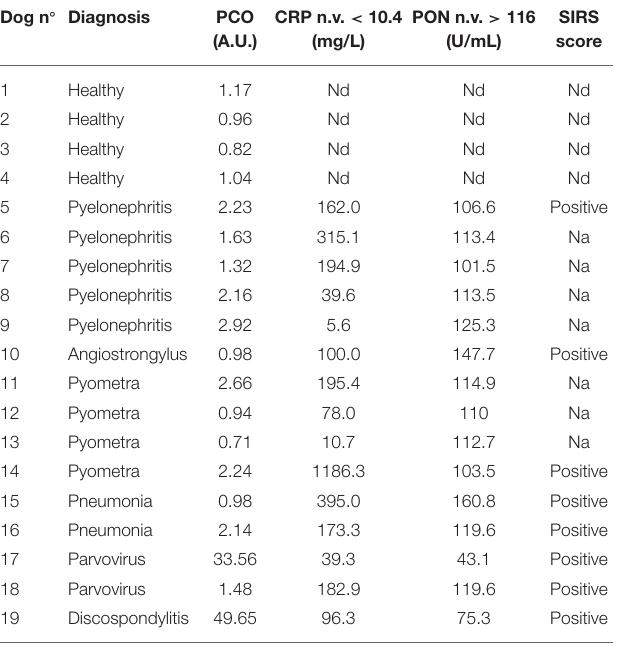
PCO,Proteincarbonyl;CRP,C-reactiveprotein;PON,Paraoxonase1;A.U.,ArbitraryUnit; n.v., normal value; Nd, Not determined. Number 13 and 14 are referred to the same dog before and after